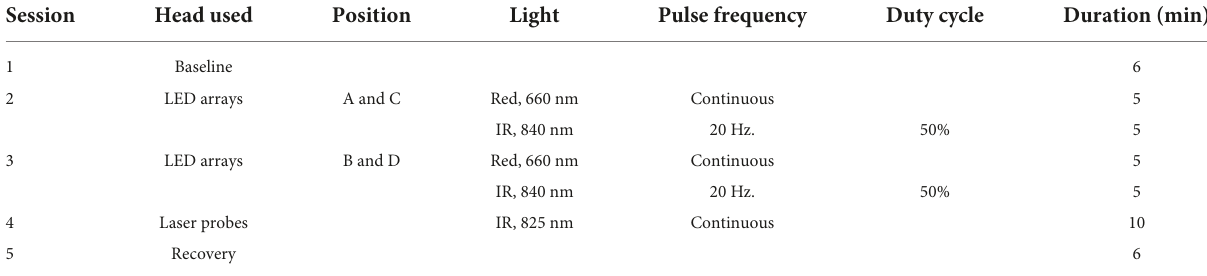
TABLE 1 Low level laser therapy protocol.